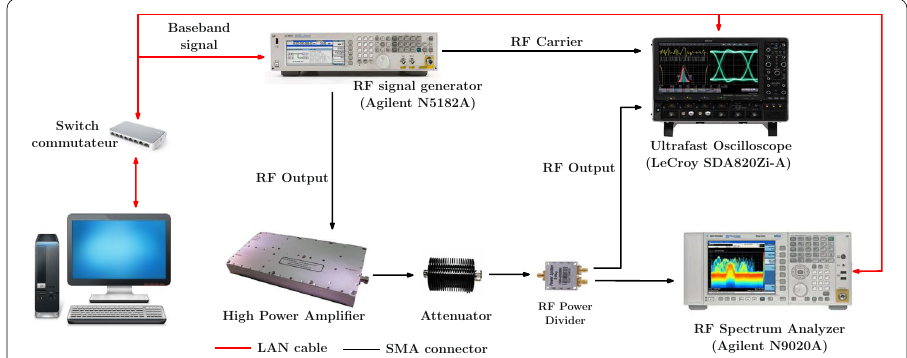
Fig. 17 Test bench for experimental